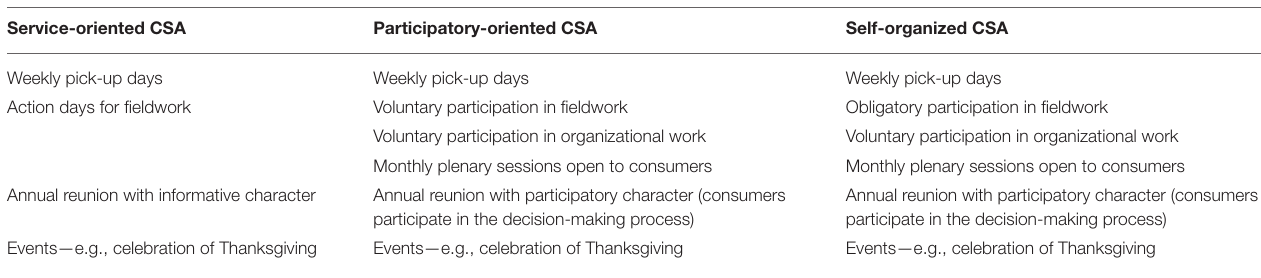
TABLE 2 | CSA types and spaces for face-to-face communication and participation (based on Gruber, 2020). Service-oriented